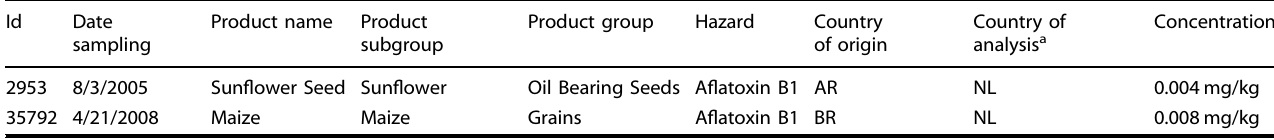
Fig. 5 The development of the machine learning module, consisting of a data pre-processing part and a model construction part. Table 5. Example records from the dataset for the AFB1 monitoring program. Records consist the information related to sample ID, date of sampling, product name, product subgroup/group, speci fi c food safety hazard, country of origin, country of analysis, and the determined concentration of one speci fi c hazard.